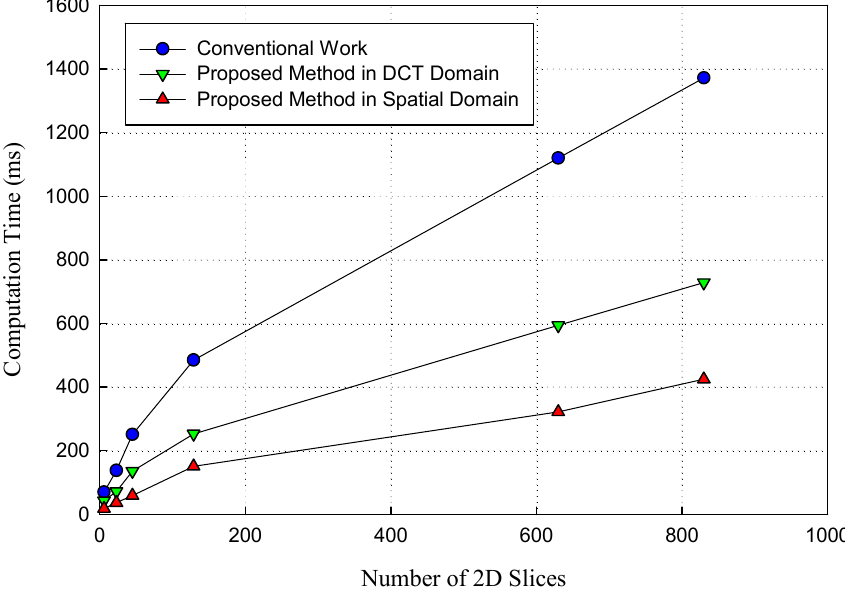
Figure 13. Performance of the proposed algorithm comparing to other methods.